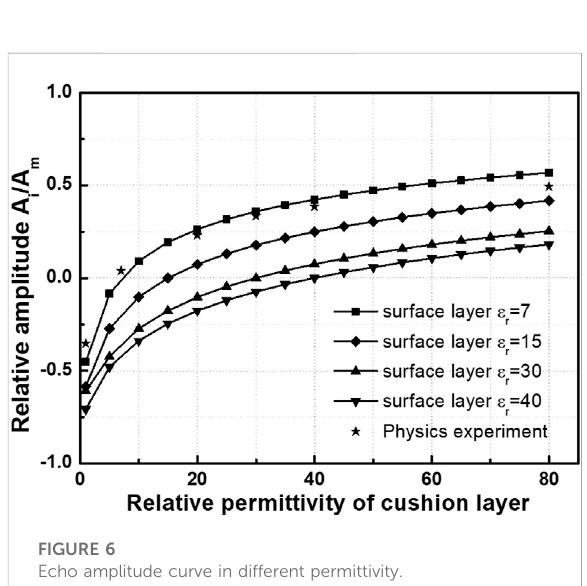
numerical simulation, there are 180 step calculations and each step calculation contains 3,391 times.